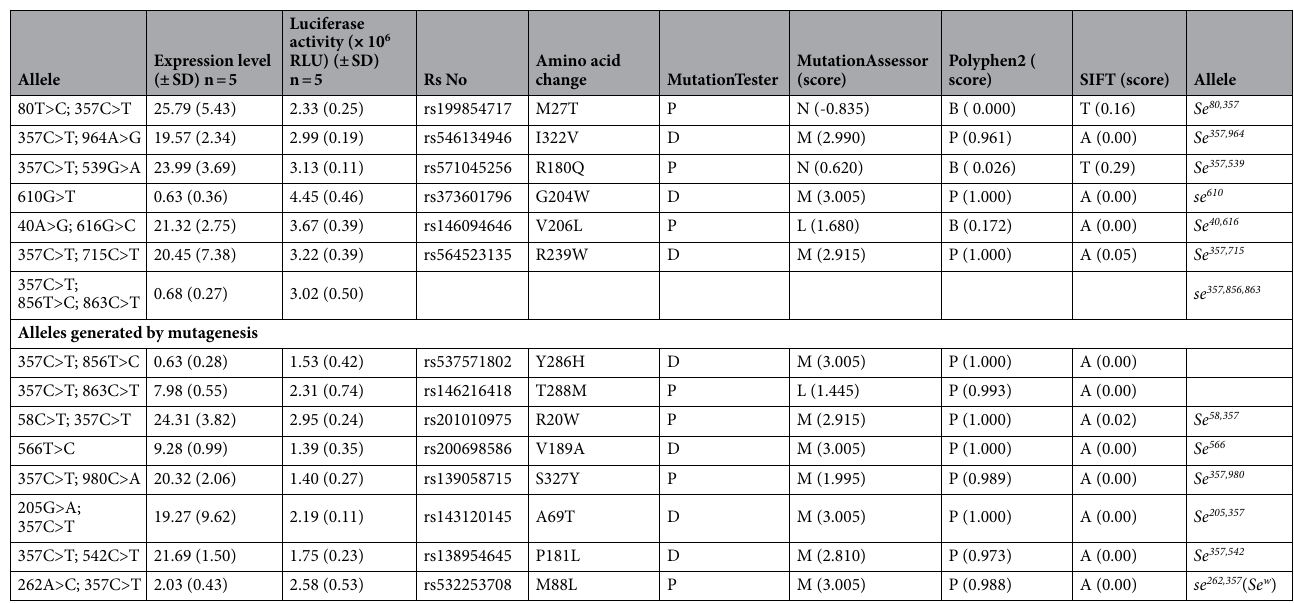
Table 3. Evaluation of candidates for nonfunctional FUT2 alleles by expression of cell surface H antigens or in silico analysis of the nonsynonymous SNP. Luciferase activities are presented by Relative Light Unit (RLU). P and D represent polymorphism and disease-causing, respectively (MutationTester). N, M, and L represent neutral, medium and low, respectively (MutationAssessor). B and P represent benign and probably damaging, respectively (Polyphen2). T and A represent tolerated and affect protein function, respectively